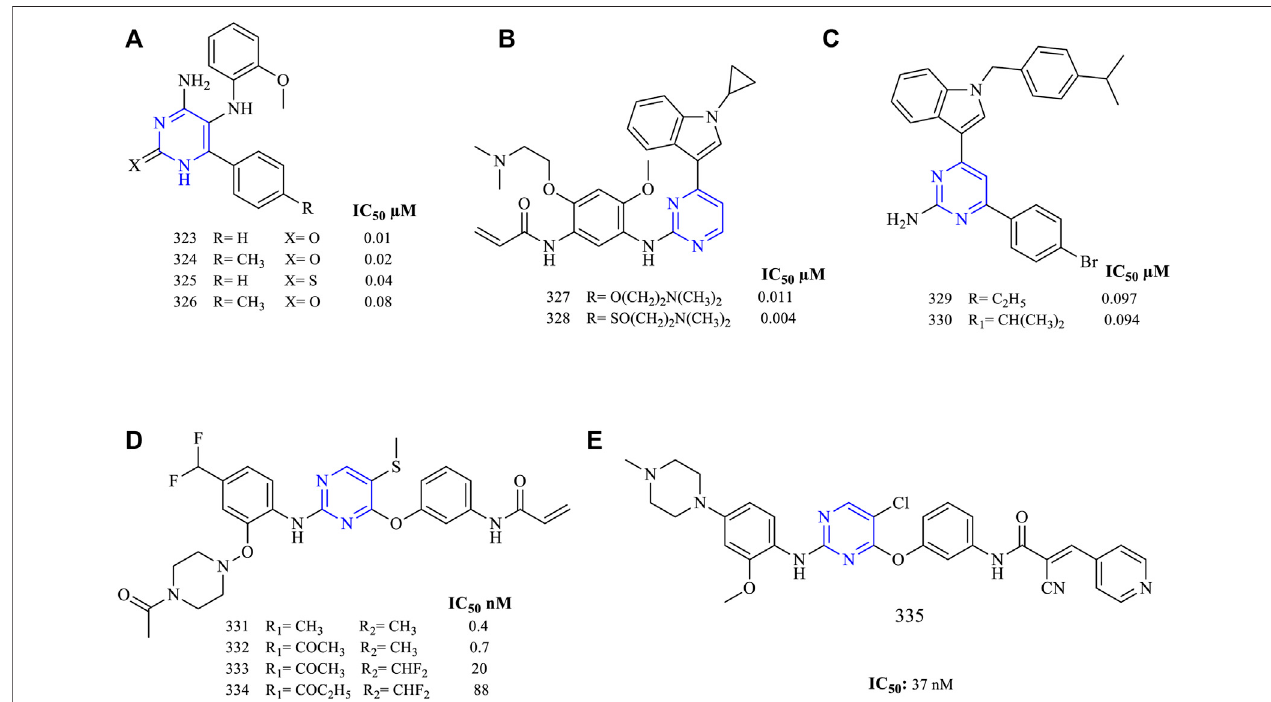
FIGURE 21 | Chemical structures of (A) 4-amino-5-((2-methoxyphenyl)amino)-6-(4-substituted) phenylpyrimidin-2(1H)-one, (B) N -(5-((4-(1-cyclopropyl-1H-indol- 3-yl)pyrimidin-2-yl)amino)-2-(substituted)-4-methoxyphenyl)acrylamide, (C) 4-(4-bromophenyl)-6-(1-(substituted)-1H-indol-3-yl)pyrimidin-2-amine, (D) N -(3-((2-((4- substituted methyl-2-((4-substituted piperazin-1-yl)oxy)phenyl)amino)-5-(methylthio)pyrimidin-4-yl)oxy)phenyl)acrylamide, and (E) N -(3-((5-chloro-2-((2-methoxy-4-(4- methylpiperazin-1-yl)phenyl)amino)pyrimidin-4-yl)oxy)phenyl)-2-cyano-3-(pyridin-4-yl)acrylamide.